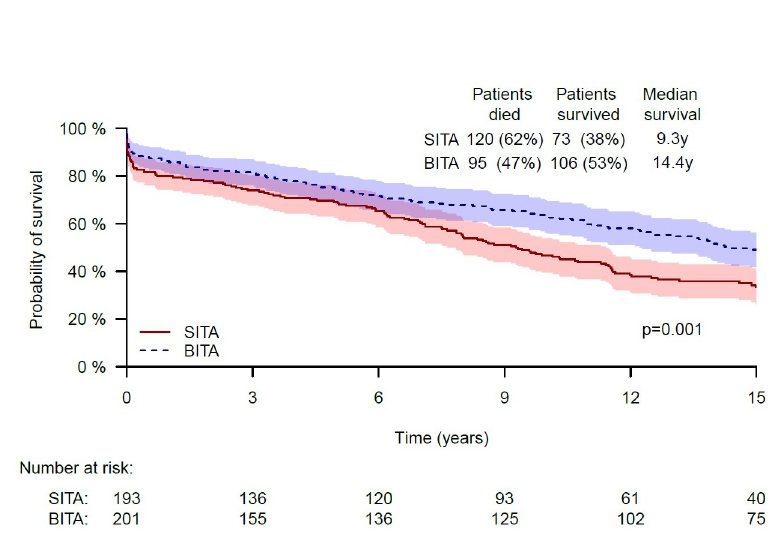
Fig 1. Kaplan-Meier curves of SITA and BITA grafting revascularizations in critical patients—Unmatched cohort.